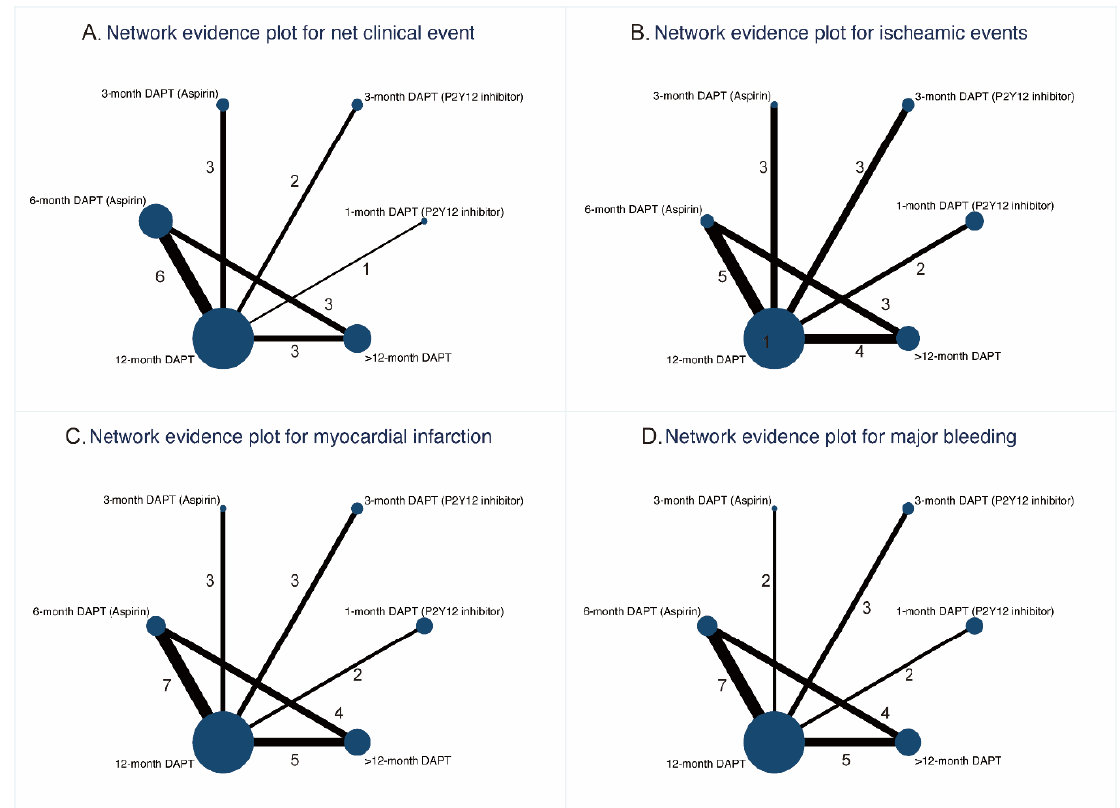
Figure 1. Network evidence plots for primary outcomes. Table 1. Comparisons for Primary Outcomes of All DAPT